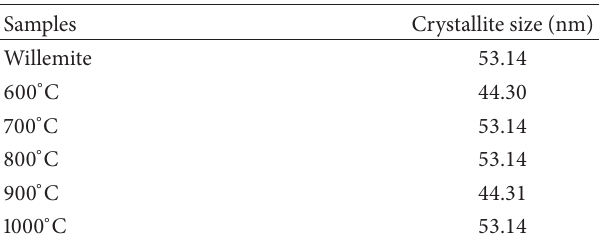
Table 1: Average crystallite size of willemite and 3wt% Eu willemite-based glass